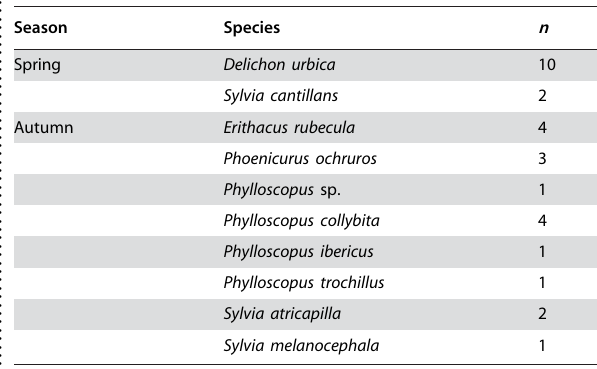
Table 1. Bird samples analysed to predict isotopic